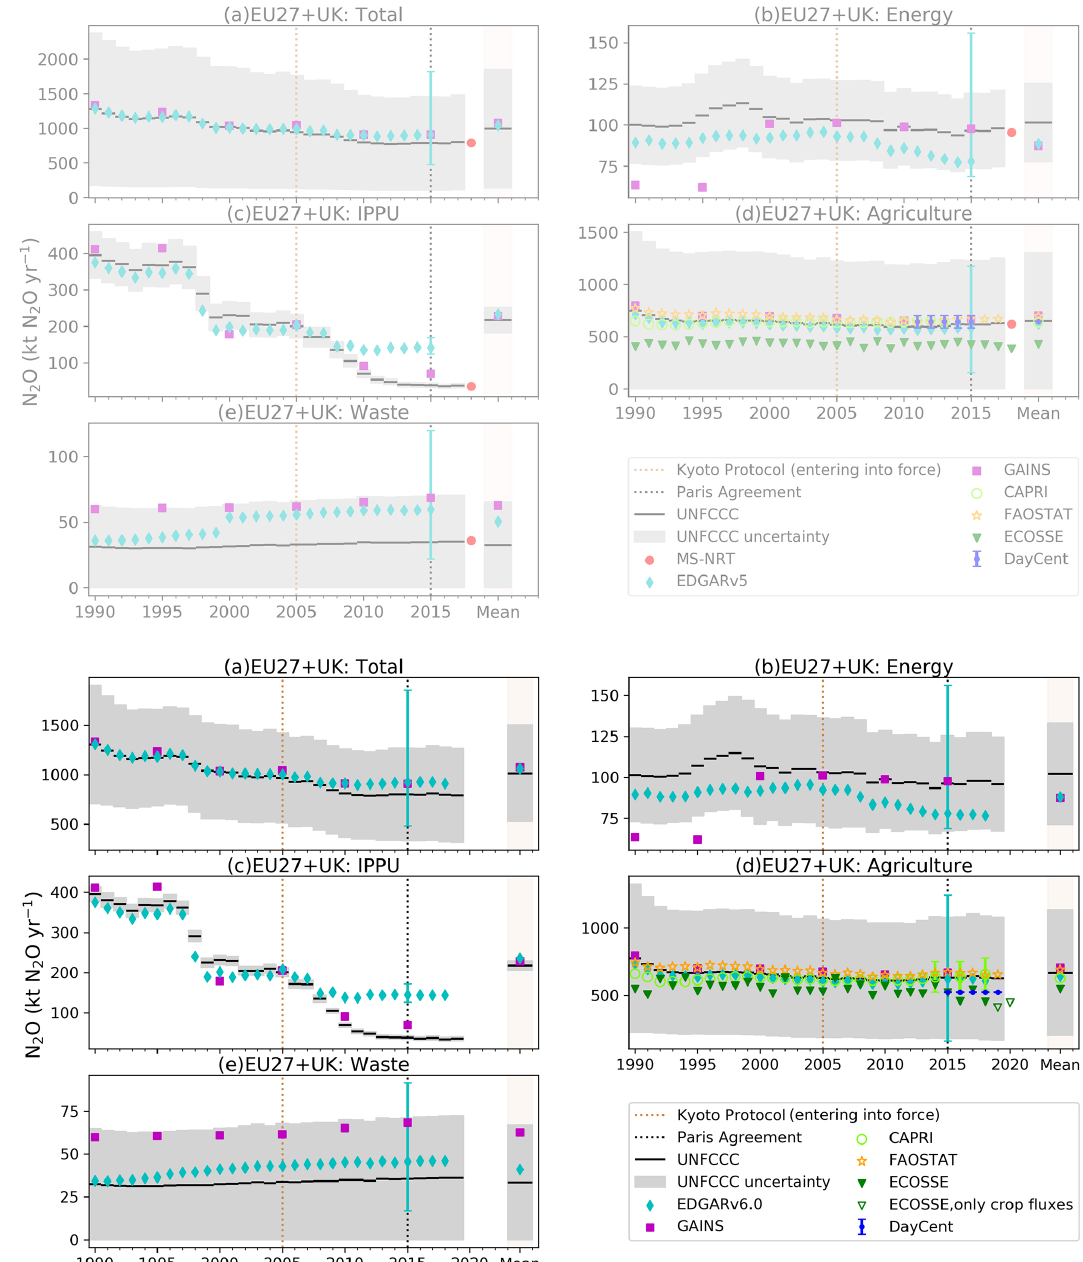
Figure 12. (a) Total annual anthropogenic N 2 O emissions (excluding LULUCF) for the EU27 + UK over time. The top plot presents previous data synthesized in Petrescu et al. (2021), while the bottom plot depicts data synthesized by the current study: (a) EU27 + UK and total sectoral emissions from (b) energy, (c) IPPU, (d) agriculture, and (e) waste from UNFCCC NGHGI (2021) submissions compared to global BU inventories for agriculture (CAPRI, ECOSSE, FAOSTAT, DayCent) and all sectors excluding LULUCF (EDGARv6.0, GAINS). CAPRI reports one value for Belgium and Luxembourg. The relative error on the UNFCCC value represents the UNFCCC NGHGI (2021) member- state-reported uncertainties computed with the error propagation method (95% confidence interval) that were gap-filled and provided for every year. The uncertainty for EDGARv6.0 is the same as that of v5.0 and calculated for 2015 as min/max values for the total and each sector (Solazzo et al., 2021) and represents the 95% confidence interval of a lognormal distribution. CAPRI reports uncertainties for the last 3 years as follows: 2014 and 2016 (17.6%) and 2018 (17.8%). The mean column represents the common overlapping period of 1990– 2018 between datasets. The last years of the time series of the respective datasets are 2019 (UNFCCC and FAOSTAT), 2018